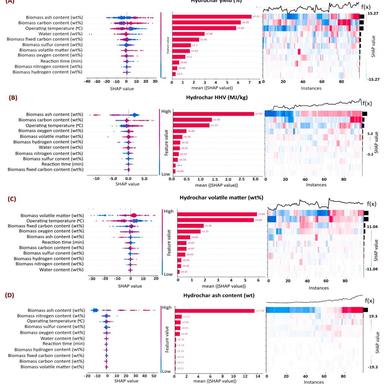
Feature importance analysis (SHAP) of the developed DTR model for predicting hydrochar production during the biomass HTC process.